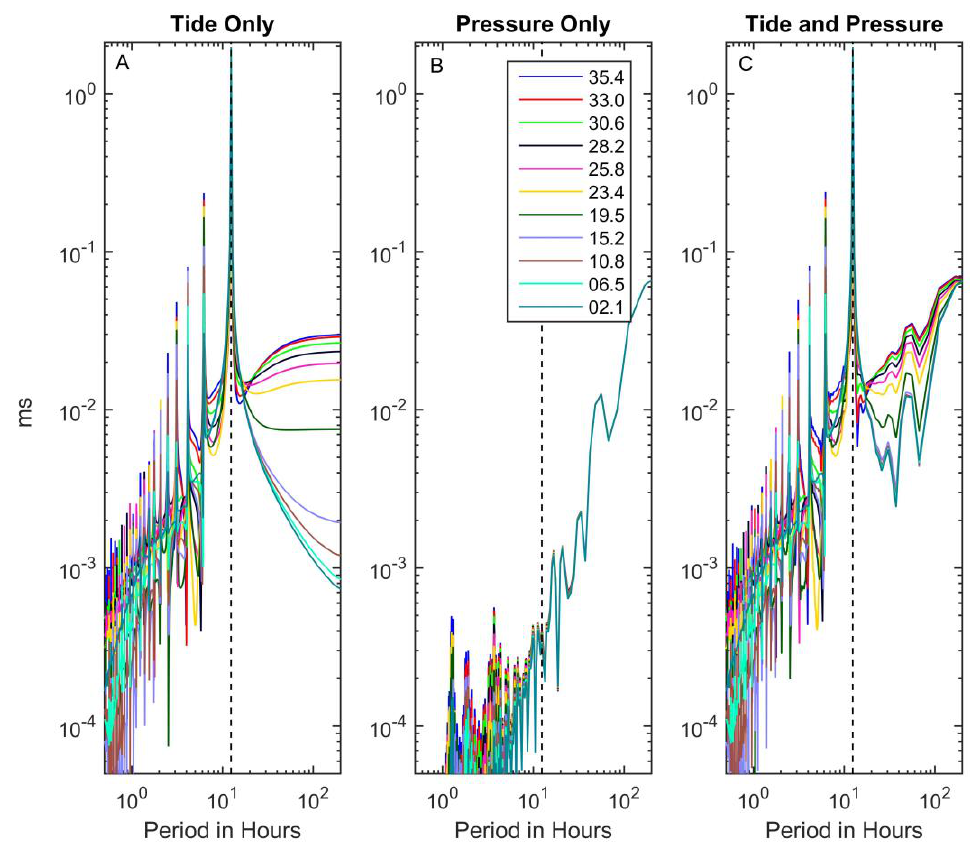
Figure 6. Spectra from Fourier transforms of selected idealized runs. ( A ) Spectra from I7 with different color lines for different locations along the channel. Legend indicates km upstream of river mouth. ( B ) Same as A but from I2. ( C ) Same as in A but for run I6. The black dashed line indicates M 2 tidal frequency.